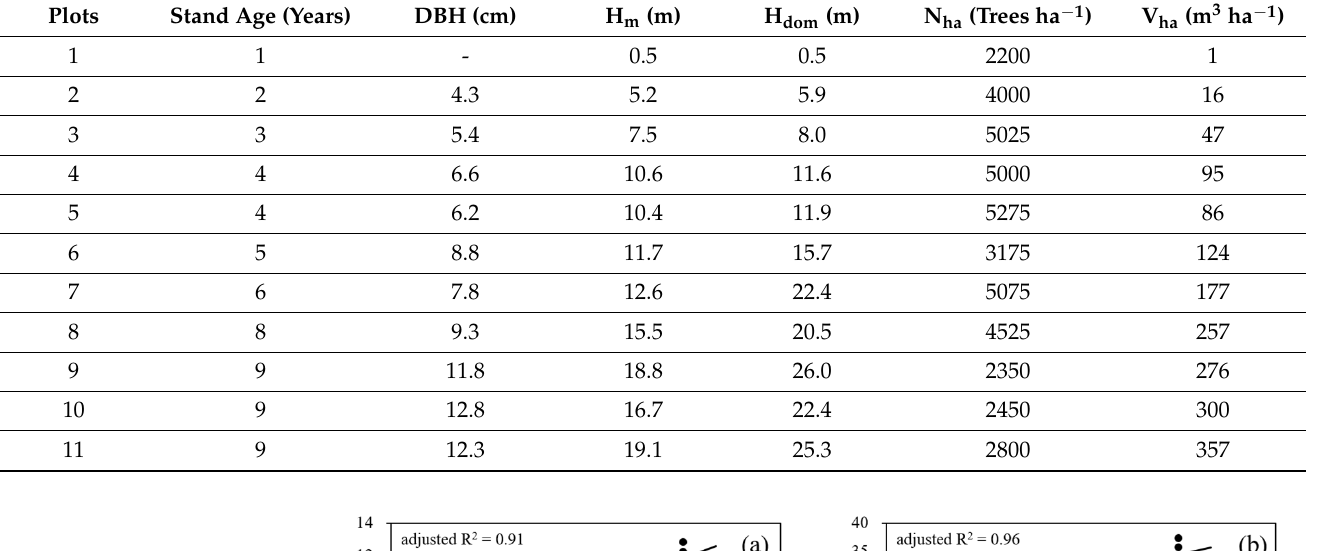
Table 2. Summary of age, diameter at breast height (DBH), mean height (H m ), dominant height (H dom ), number of trees per hectare (N ha ), and stand volume per hectare (V ha ) for each plot.